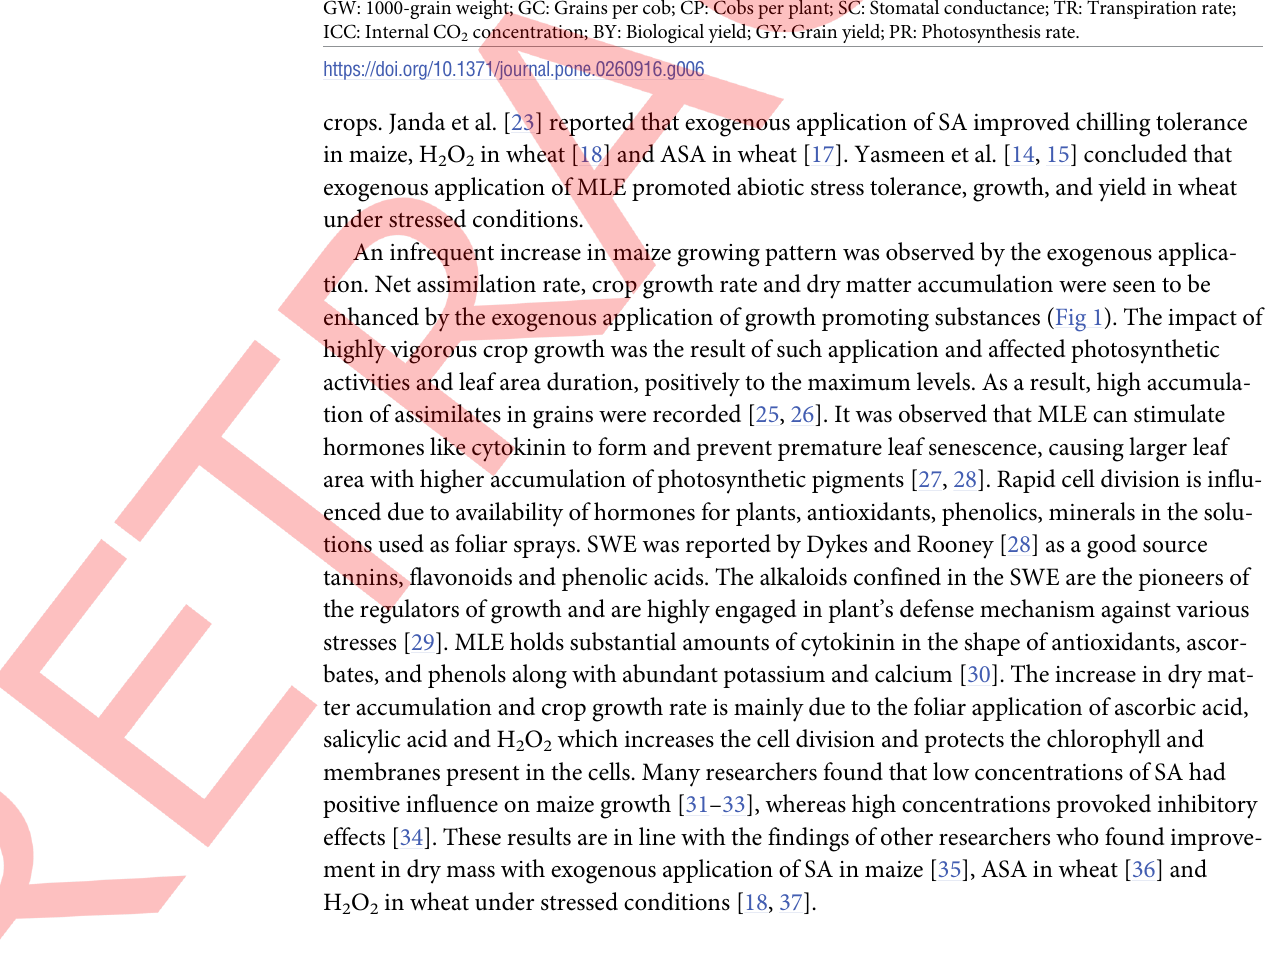
Fig 6. Principal component analysis among foliar applied growth promoting agents, sowing dates and physiological, yield, and related attributes of maize. Clustering of variables has been shown according to highest cosine values on F1 (blue shading) and F2 (red shading). T0: Control; T1: Water spray; T2: SWE+H 2 O 2 ; T3: MLE +H2O2; T4: